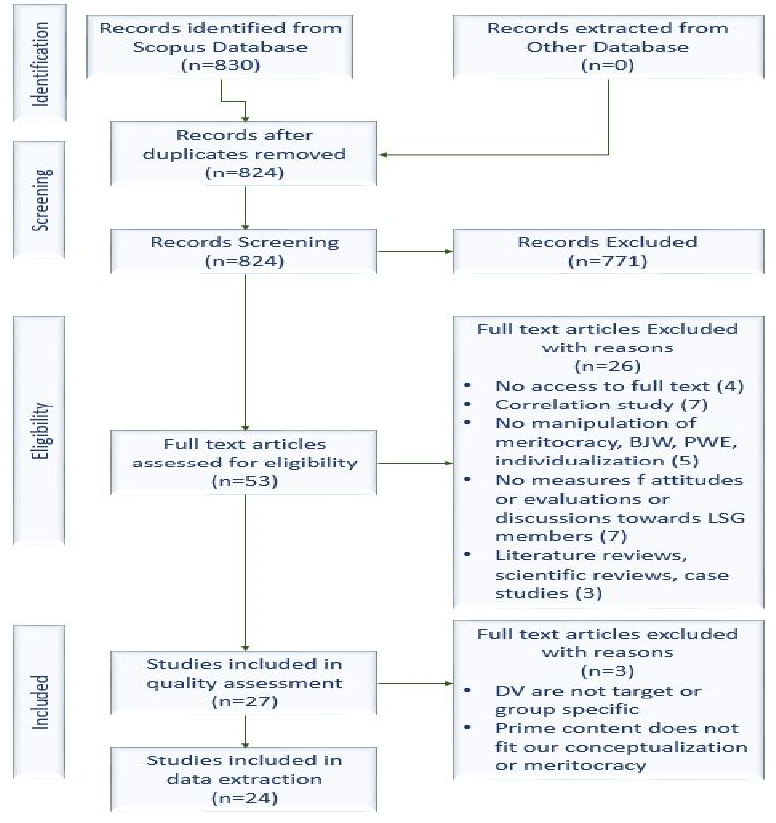
Figure 4. PRISMA framework for reviewing the articles.